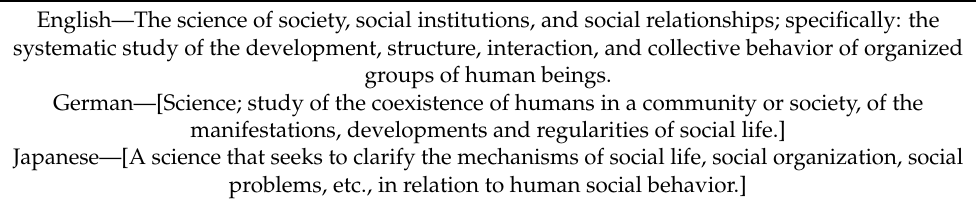
Table 3. Science, practical and reliable by definition. English—The intellectual and practical activity encompassing the systematic study of the structure and behavior of the physical and natural world through observation and experiment. German—[Reasoned/logical, orderly, reliable knowledge-producing research activity in a particular